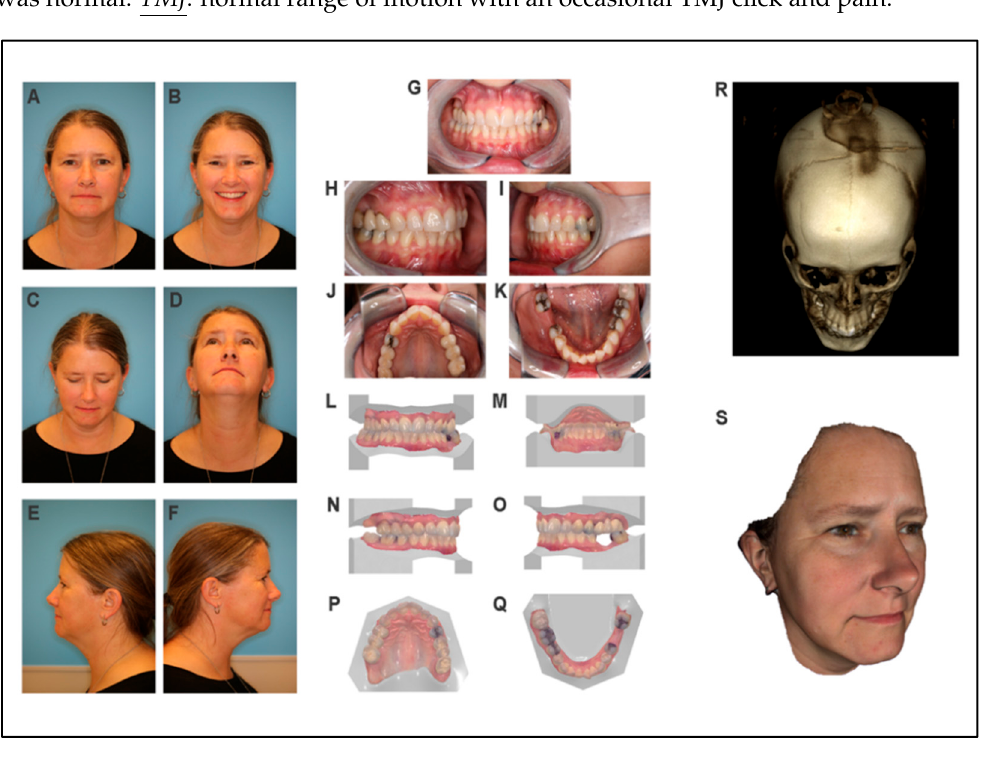
Figure 2. Clinical assessment of the unaffected mother of the proband . ( A – F ) Two-dimensional pho- tographs of the proband’s mother. ( G – K ) Intraoral photographs. ( L – Q ) Intraoral scan images. ( R ) Three-dimensional CBCT scan image. ( S ) Three-dimensional soft tissue